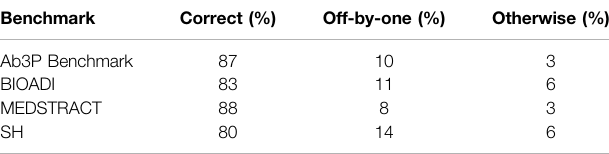
TABLE 4 | Many LF candidates from BERT-SQuAD are off by one word.